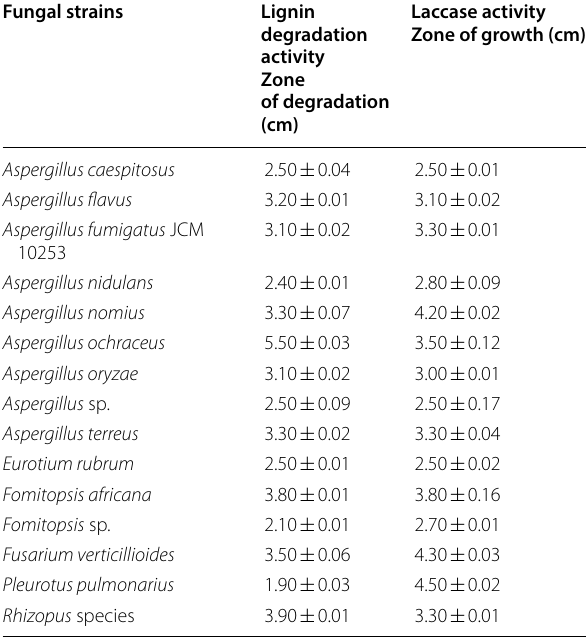
Table 3 Summary of plate assay method for lignin degradation and laccase activity of fungal isolates